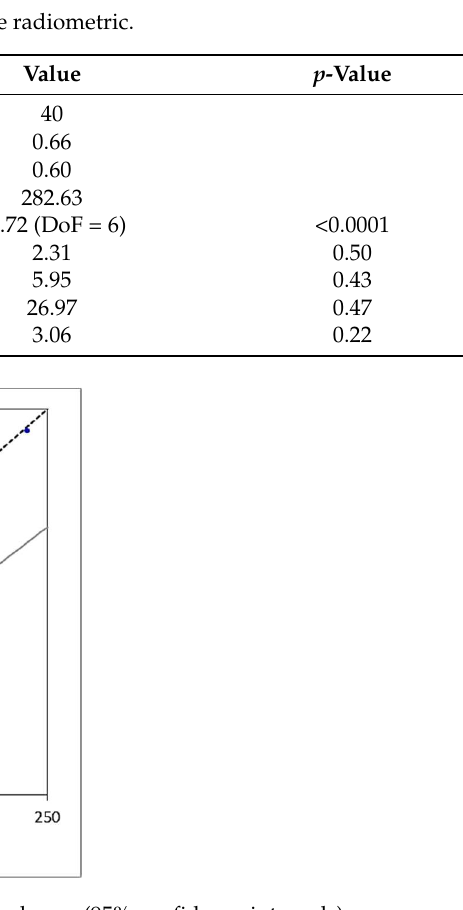
Figure 8. Predicted SGR values versus the measured ones (95% confidence intervals). Table 3. Descriptive statistics of extracted airborne